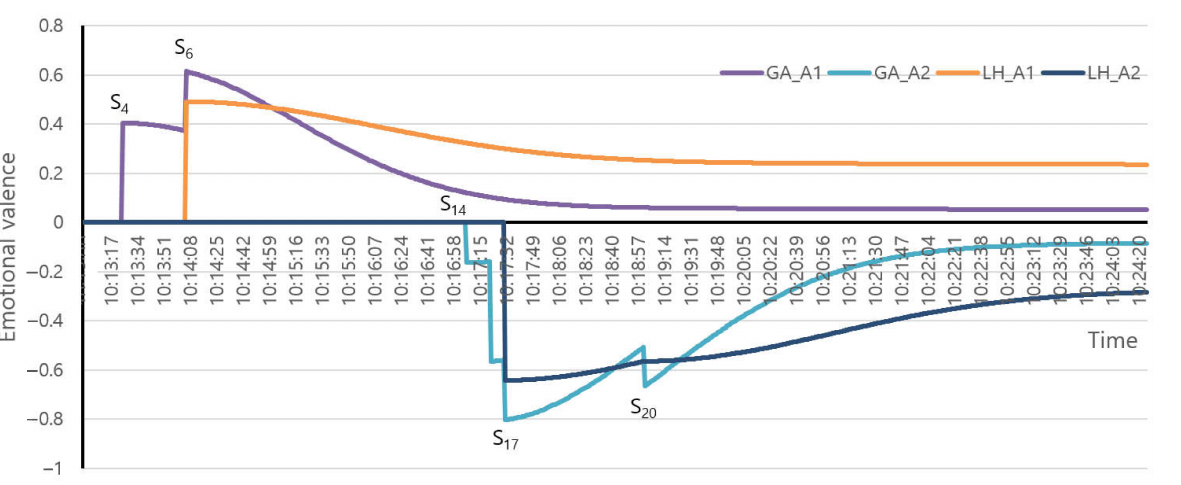
Figure 8. The scenes of the experiments and the object recognition results of each event (captions are the sentence numbers in Table 7). In the case of S 4 and S 6 , a user (A 1 ) as an agent did the positive action to the robot, but the other user (A 2 ) did the negative in the events of S 14 to S 20 . Table 7 shows the sentential memory of each event with the emotional valence, which was obtained from the emotional appraisal system. Events that occurred with agents and objects in front of the robot were stored in the sentential memory with chronological order. In the case of S 1 –S 3 and S 11 –S 13 , new agents, A 1 and A 2 , appeared, and the robot had a neutral emotional valence to them at first.